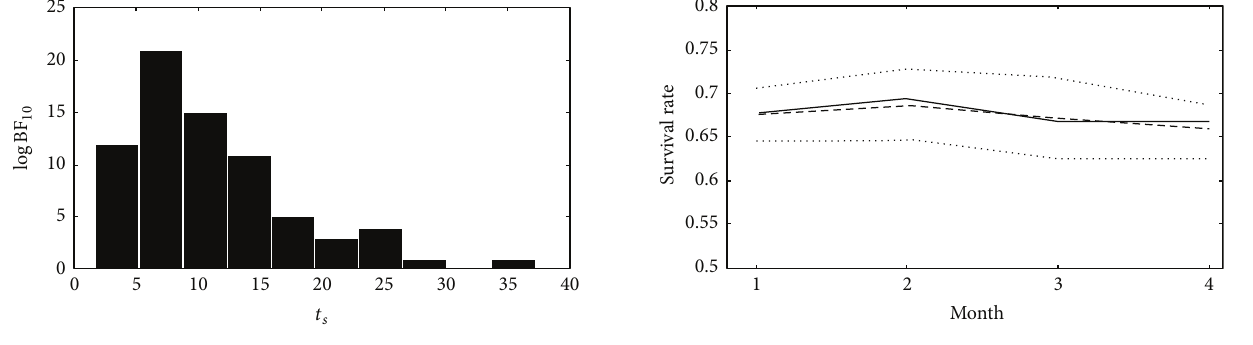
Figure 3: Histogram of log BF 10 of posterior distribution for each 𝑡 𝑠 .